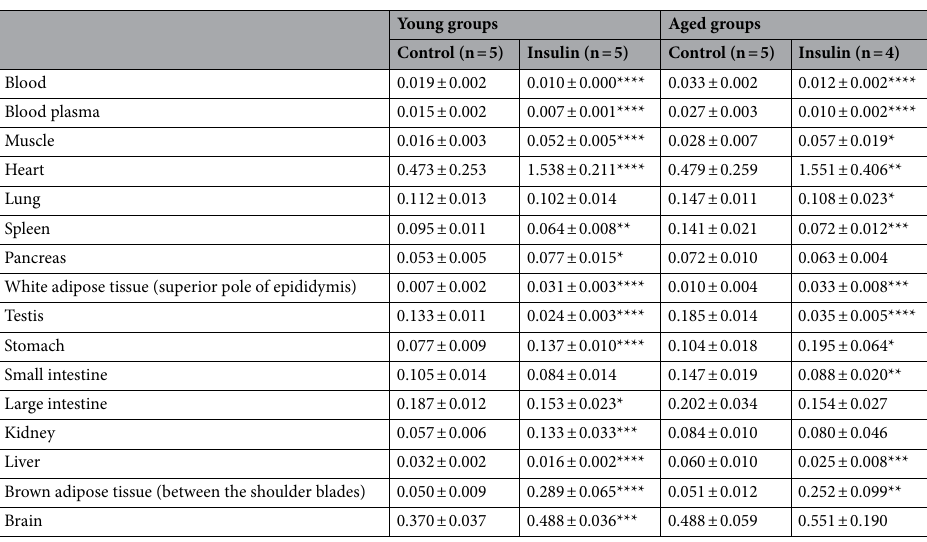
Table 3. Organ 18 F-FDG accumulation in mice (%ID/g/kg). Data in parentheses are mean ± SD. Control,